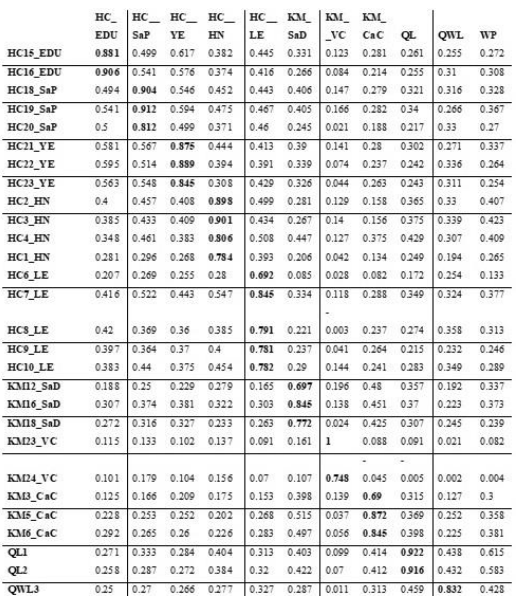
Table 6: Cross Loadings